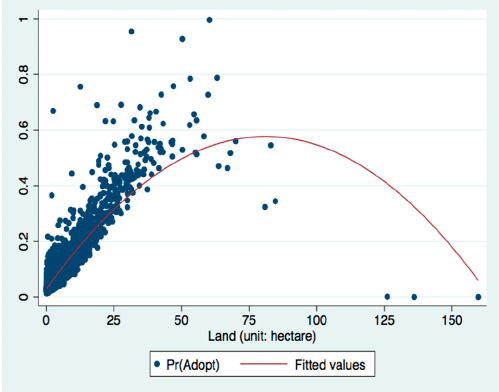
Figure 3. Predicted probability with respect to land